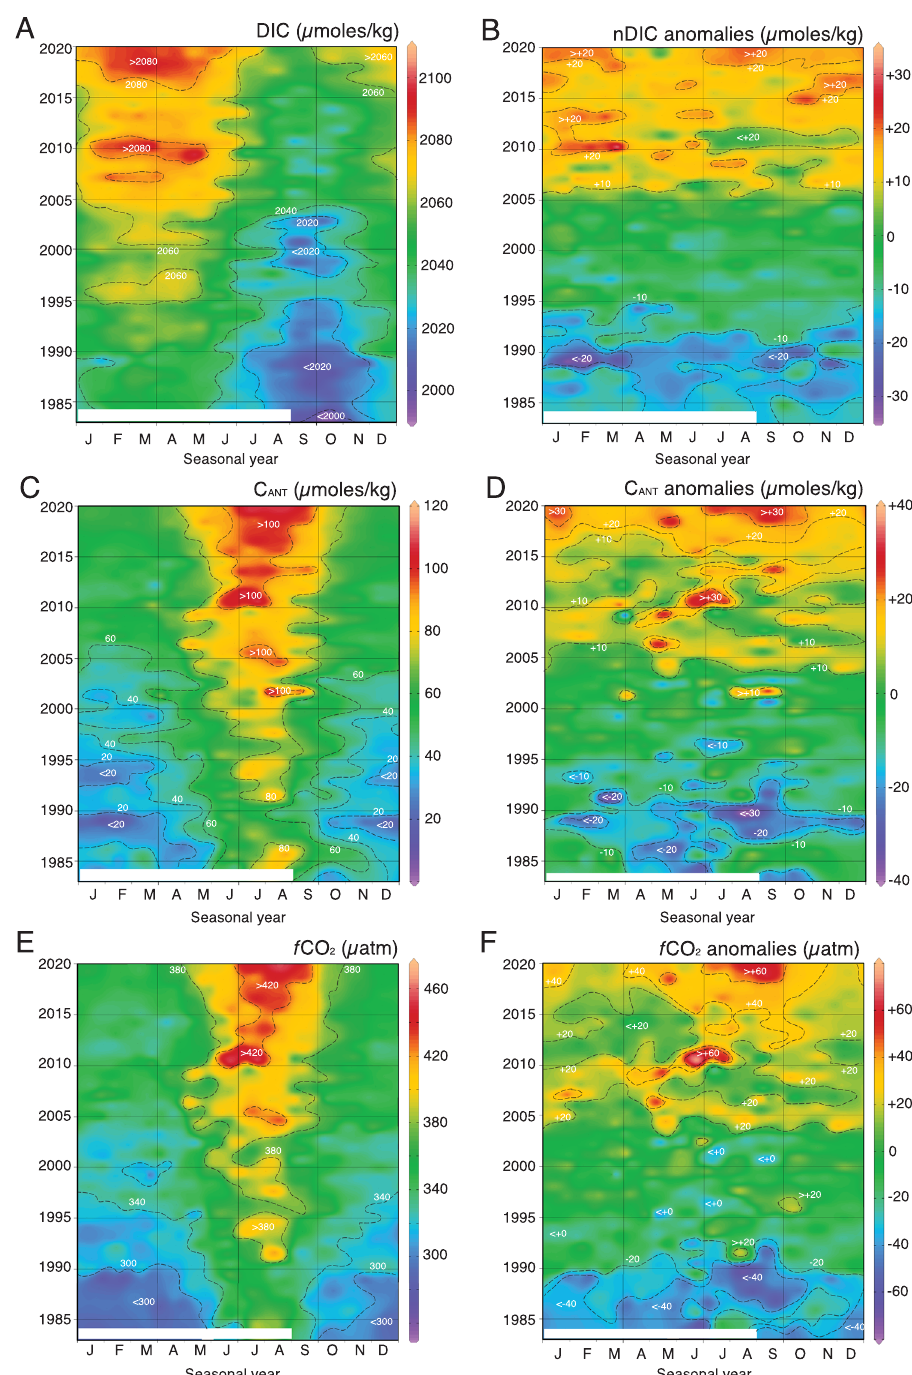
Fig. 4 Seawater CO 2 – carbonate properties at BATS (1988 – present) with earlier data (1983 – 1988) from Hydrostation S. a Scatter plot of DIC ( µ moles kg − 1 ). b Scatter plot of nDIC anomalies ( µ moleskg − 1 ). c Scatter plot of C ANT ( µ moles kg − 1 ). d Scatter plot of of C ANT anomalies ( µ moles kg − 1 ). e Surface f CO 2 ( µ atm). f Surface f CO 2 anomalies ( µ atm). Dashed lines for contours are